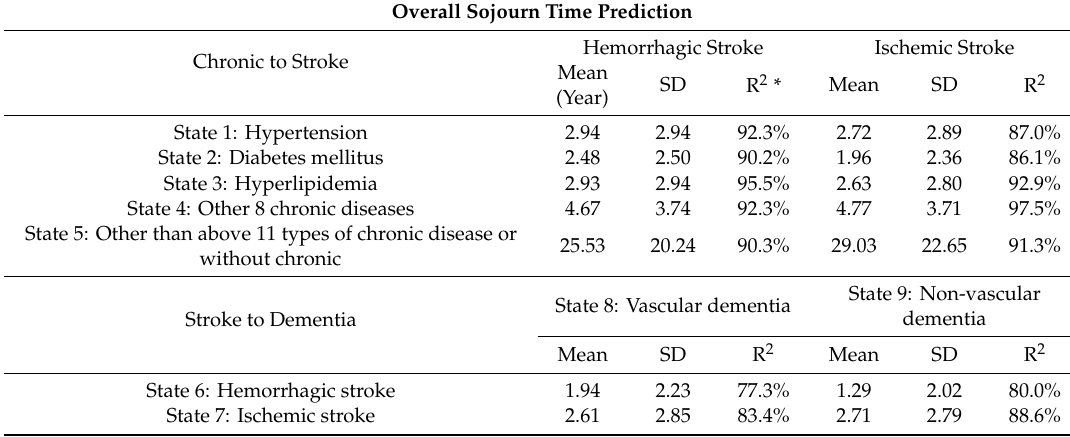
Table 6. Sojourn time